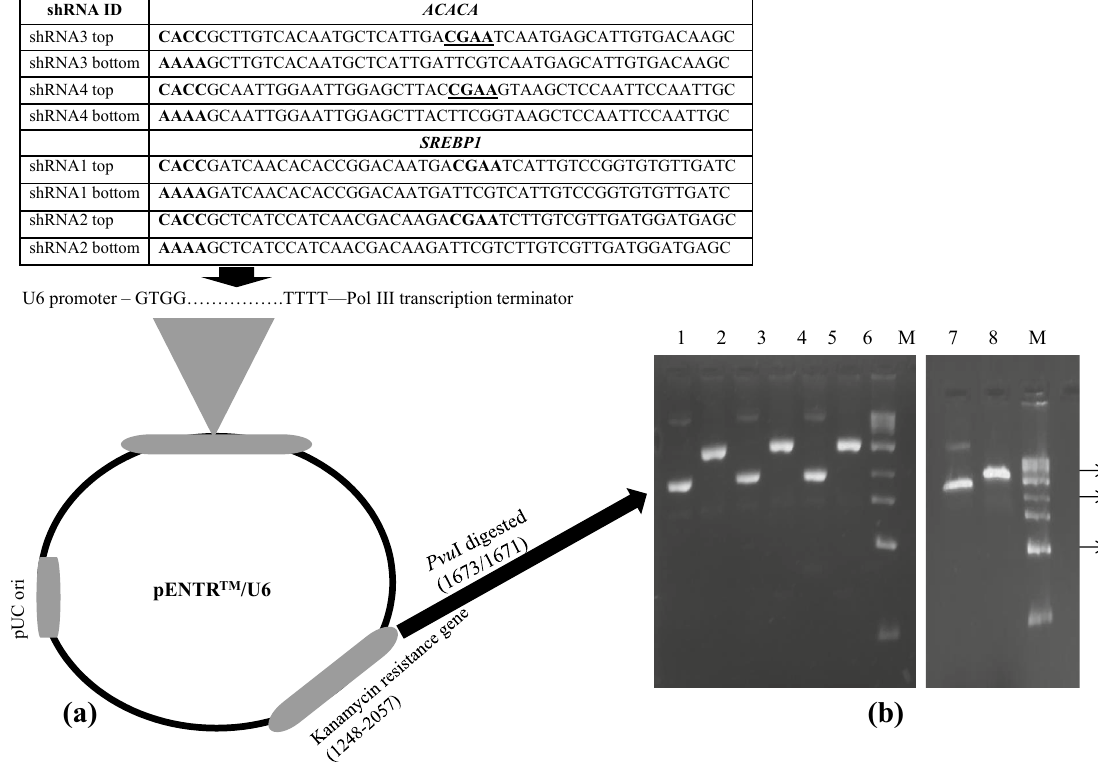
Figure 6. ( a ) pENTR/U6 entry vector where shRNA molecules were cloned. ( b ) shRNA cassette of ACACA and SREBP1 genes linearized by digestion with Pvu I enzyme. 1 = Pvu I digested shRNA3 cassette of ACACA; 3 = Pvu I digested shRNA4 cassette of ACACA; 5 = Pvu I digested shRNA1 cassette of SREBP1; 7 = Pvu I digested shRNA2 cassette of SREBP1; 2 = Undigested shRNA3 cassette of ACACA; 4 = Undigested shRNA4 cassette of ACACA; 6 = Undigested shRNA1 cassette of SREBP1; 8 = Undigested shRNA1 cassette of SREBP2; M = 1 Kb ladder DNA marker. The Pvu I restriction site (1673/1671) is present within the Kanamycin resistance gene (1248–2057) to neutralize the antibiotic resistance gene. The shRNA constructs have been mentioned in this